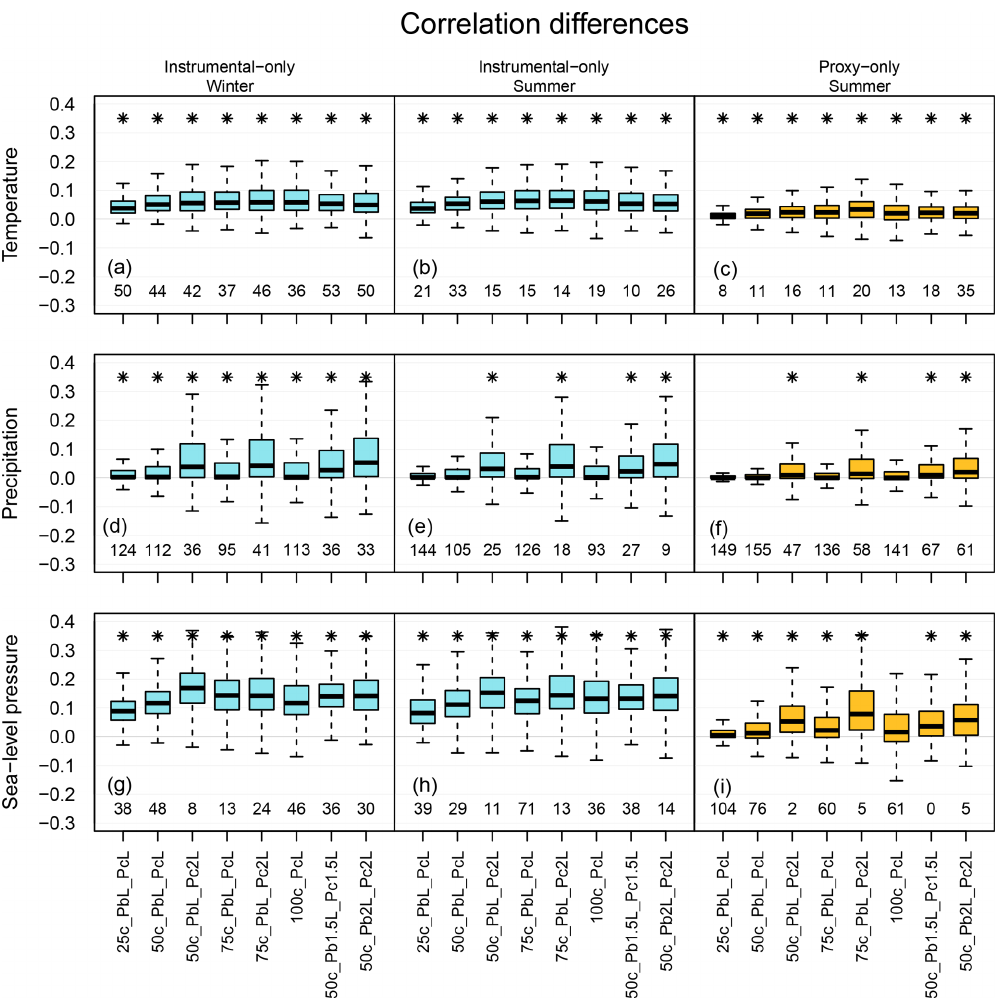
Figure 5. Distribution of correlation coefficients differences between the mixed background-error covariance matrix experiments and the original setup over the ENH region. Panels (a) , (d) and (g) show the skill of the reconstruction in the winter seasons, while panels (b) , (c) , (e) , (f) , (h) and (i) show it for the summer season. The labels on the x axis indicate the experiments. Box plot, color, number and asterisk are the same as in Fig.